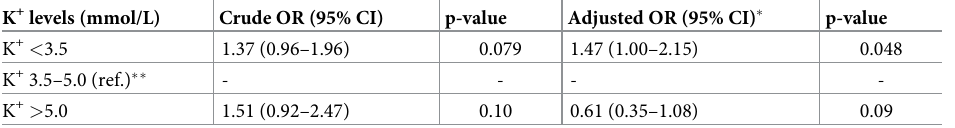
Table 4. Associations between K + levels and the outcome of hospitalization or death. K + levels (mmol/L) Crude OR (95% CI) p-value Adjusted OR (95% CI) � p-value K + < 3.5 1.37 (0.96–1.96) 0.048 K + 3.5–5.0 (ref.) �� - - - - K + > 5.0 � Model adjusted for age, gender, estimated glomerular filtration rate, hemoglobin and thiazide diuretics. �� The reference group is normokalemia: